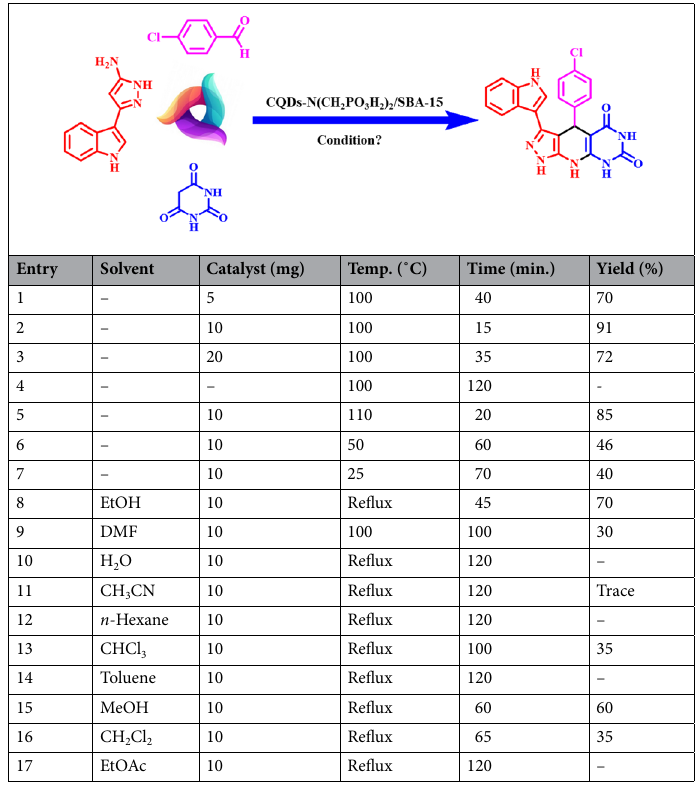
Table 1. Effect of various amounts of catalysts, temperature and solvents in synthesis of pyrazolo[4 ′ ,3 ′ :5,6] pyrido[2,3- d